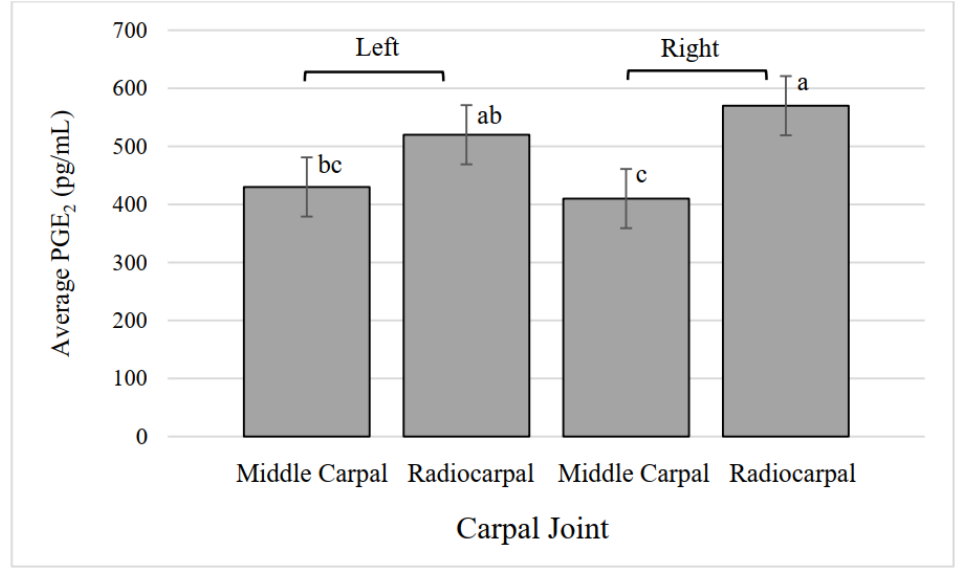
Figure 7. Average prostaglandin E 2 (PGE 2 ) concentration in middle carpal and radiocarpal joints. a,b,c Values that lack common superscripts differ ( p = 0.007).